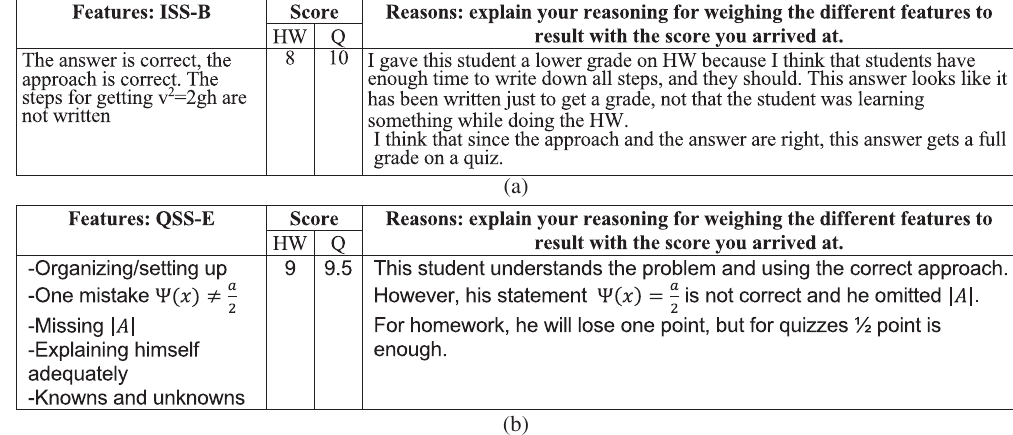
FIG. 5. (a) One component of a sample TA ’ s worksheet (transcribed) related to introductory student solution ISS-B which was part of the pregrading activity. (b) One component of a sample TA ’ s worksheet (transcribed) related to advanced QM student solution QSS-E which was part of the pregrading